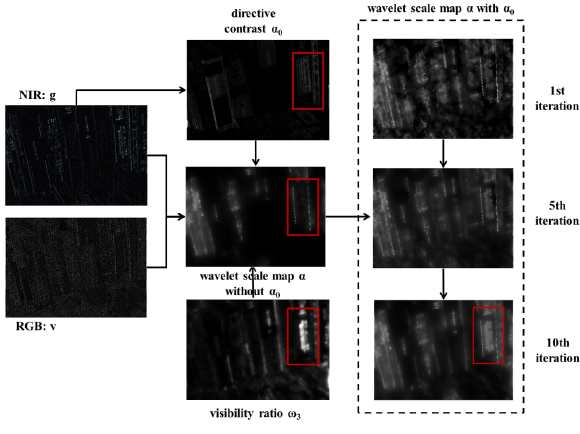
Figure 3. Wavelet scale map